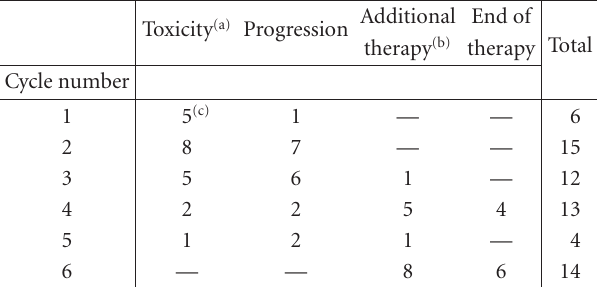
Table 2: Number of patients and dose of ifosfamide during the first 6 cycles of treatment.